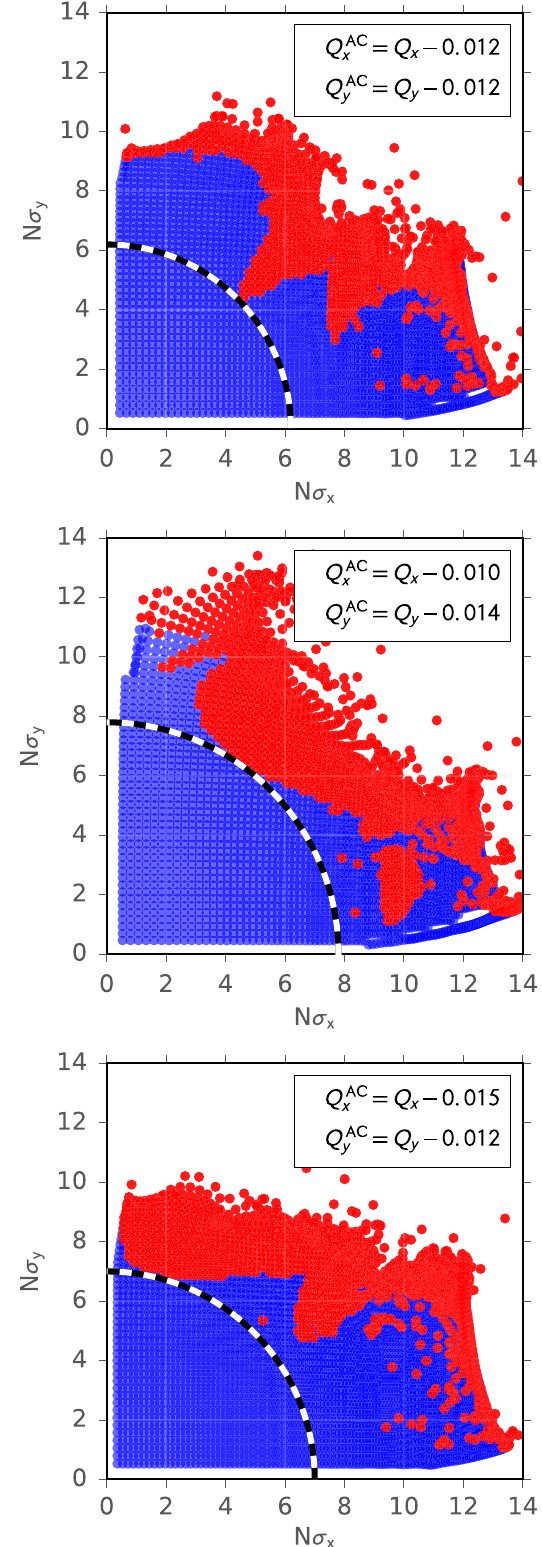
FIG. 6. Forced dynamic aperture results for three different ac dipole driving tunes at top energy the natural tunes are Q x ¼ 0 . 31 and Q y ¼ 0 . 32